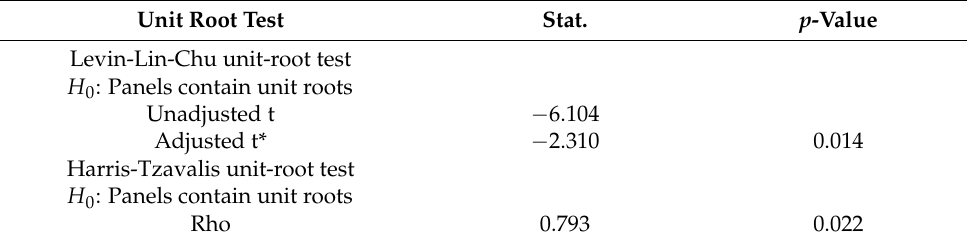
Table 4. Unit root test.